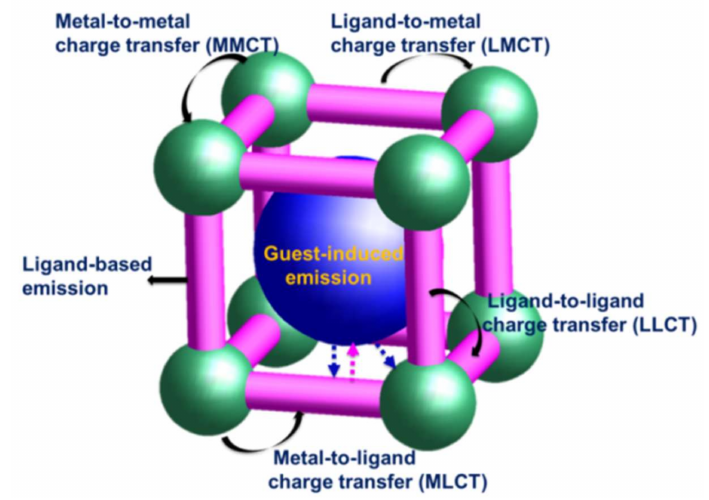
Figure 2. Emission modes of